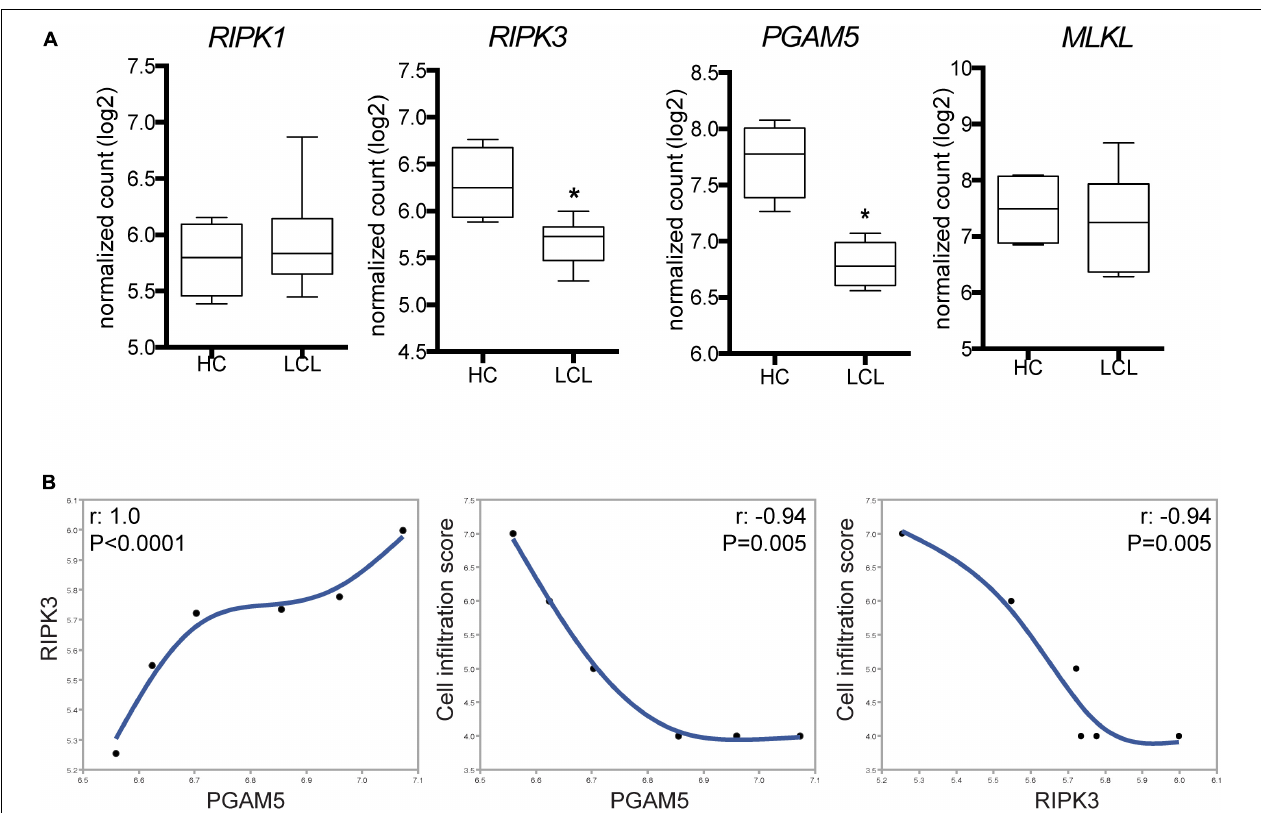
FIGURE 1 | Differential expression of selected genes of necroptosis pathways in skin lesions from patients with tegumentary leishmaniasis. Total mRNA was extracted from lesion biopsy specimens obtained from six patients with localized cutaneous leishmaniasis (LCL) and normal skin samples. Indicated mRNA transcripts of host-specific cellular genes were quantified by nCounter (NanoString), including the pan-leukocyte gene CD45, for normalization of immune infiltration into tissues. (A) RIPK1, RIPK3, PGAM5, and MLKL expression in normal skin samples (HC) and LCL skin samples. Gene expression relative to CD45 is shown. Lines and boxes represent medians and interquartile ranges, and whiskers represent minimum and maximum values. Data were compared using the Mann–Whitney U -test. ∗ P < 0.05 . (B) Correlation between the inflammatory cell infiltration score values and the RIPK3 and PGAM5 expression levels in skin biopsies. The Spearman rank test was used to assess